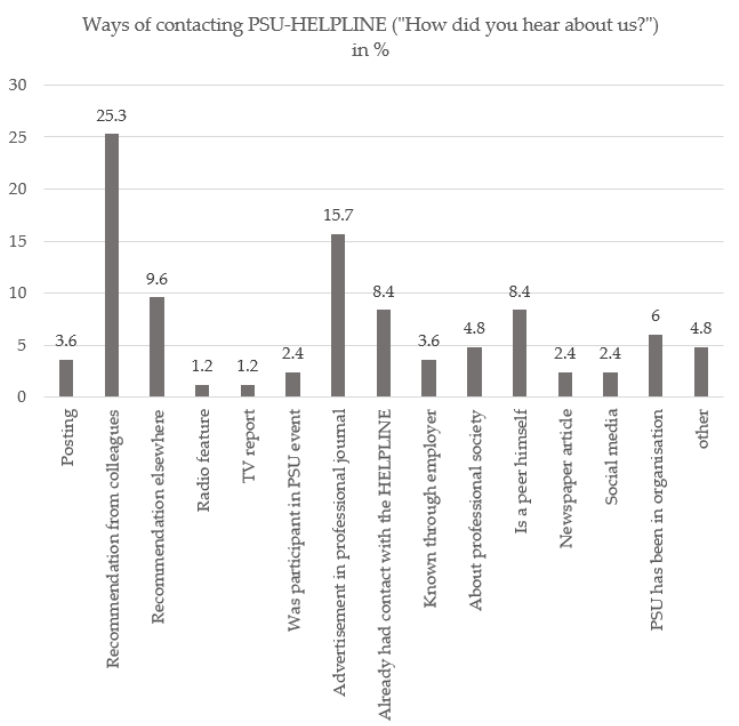
Figure 1. Ways of contacting PSU ‐ HELPLINE (“How did you hear about